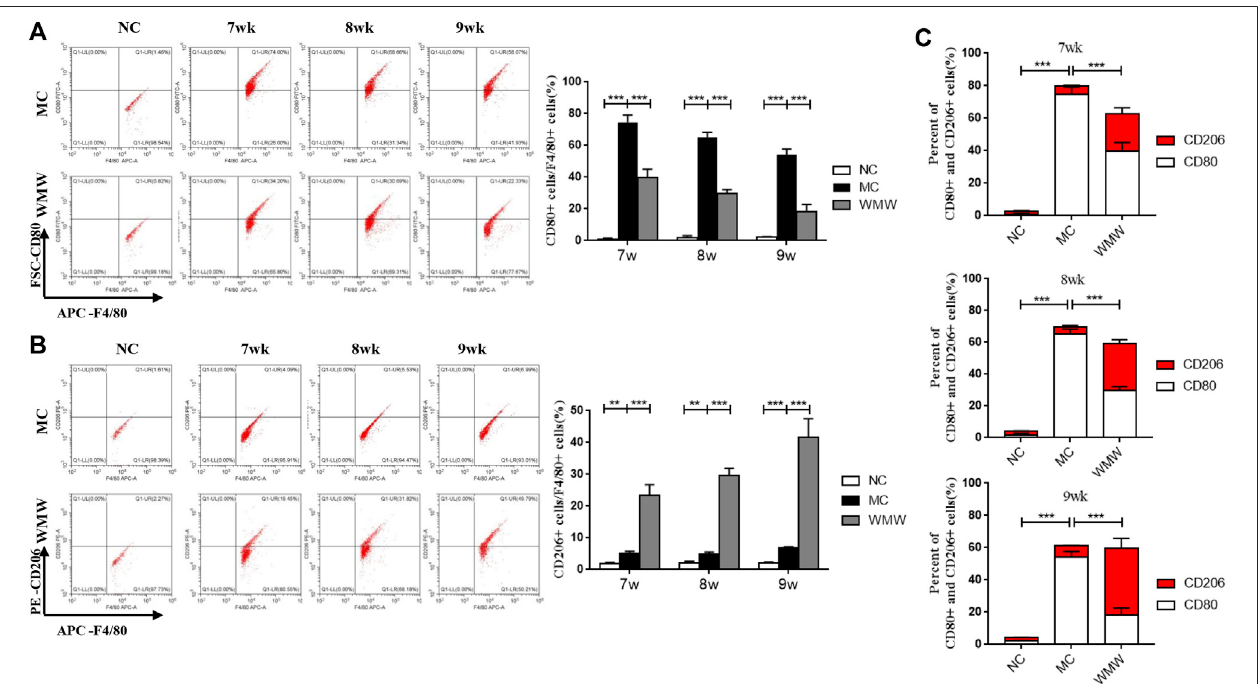
FIGURE 7 | WMW Impact the M1 versus M2 Polarization of Macrophages in mice with ulcerative colitis induced by DSS (A) The proportion of M1 macrophages in mice colon tissues at different time points was detected by fl ow cytometry. (B) The proportion of M2 macrophages in mice colon tissues at different time points was detected by fl ow cytometry. (C) Ratio of M1/M2 macrophages changes at different time points in the different groups. n = 3, means ± SEM.* p < 0.05, ** p < 0.01, *** p < 0.001.